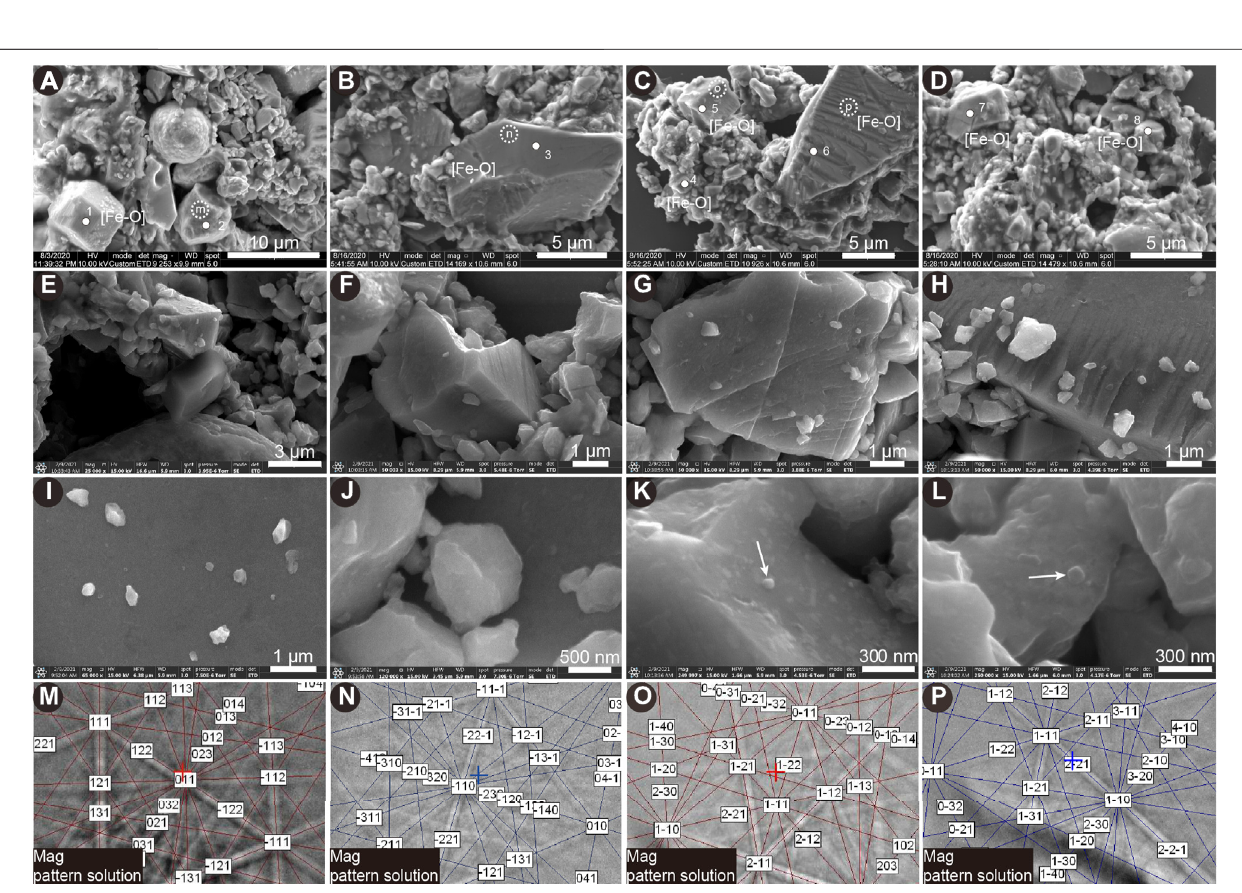
Frontiers in Earth Science |